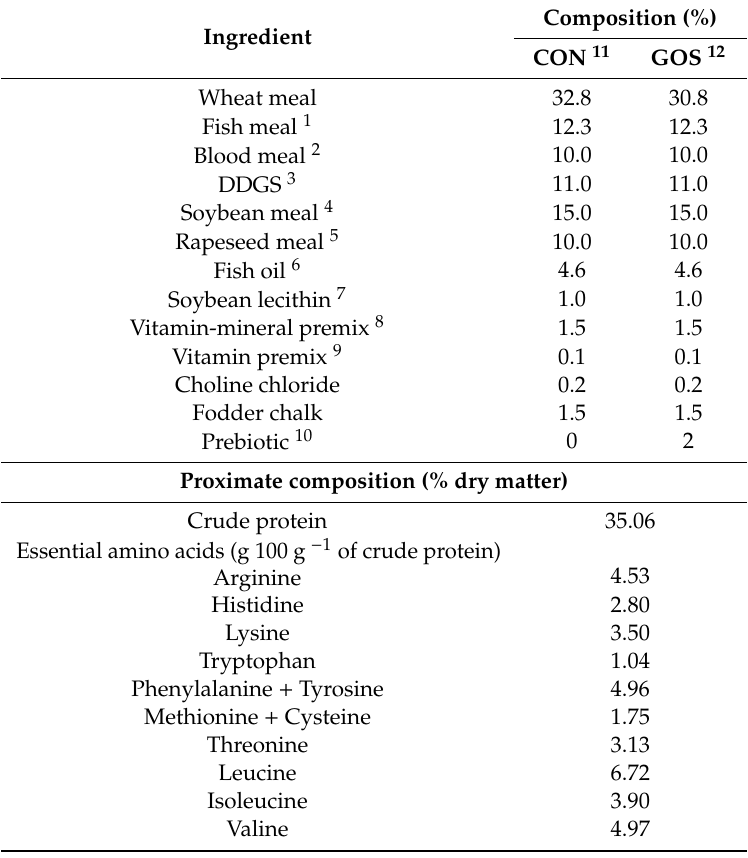
Table 1. Dietary formulation and proximate composition of the feed.